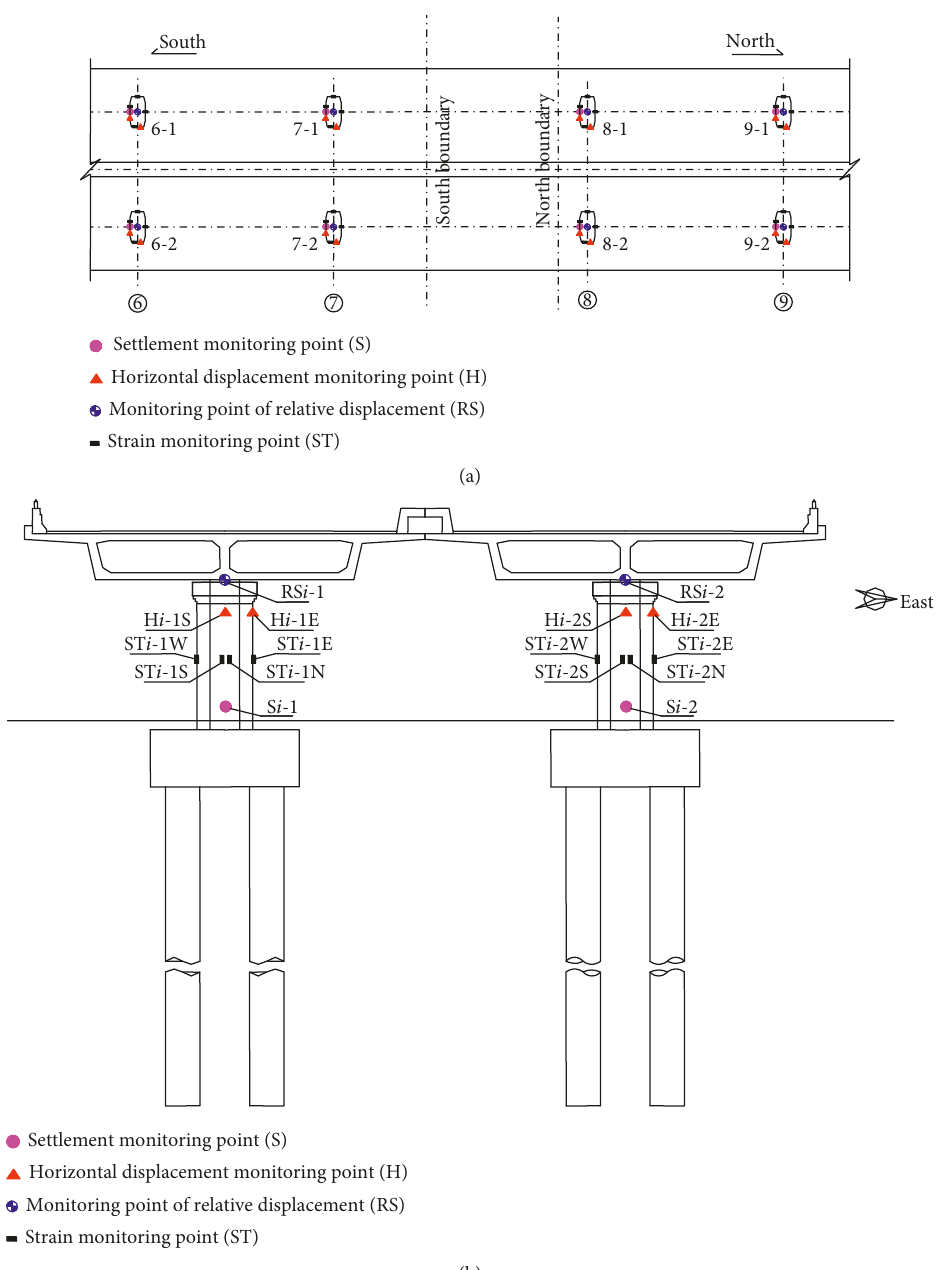
Figure 11: Layout of monitoring points. (a) Plan of monitoring points. (b) Monitoring points on piers ( i stands for the axis